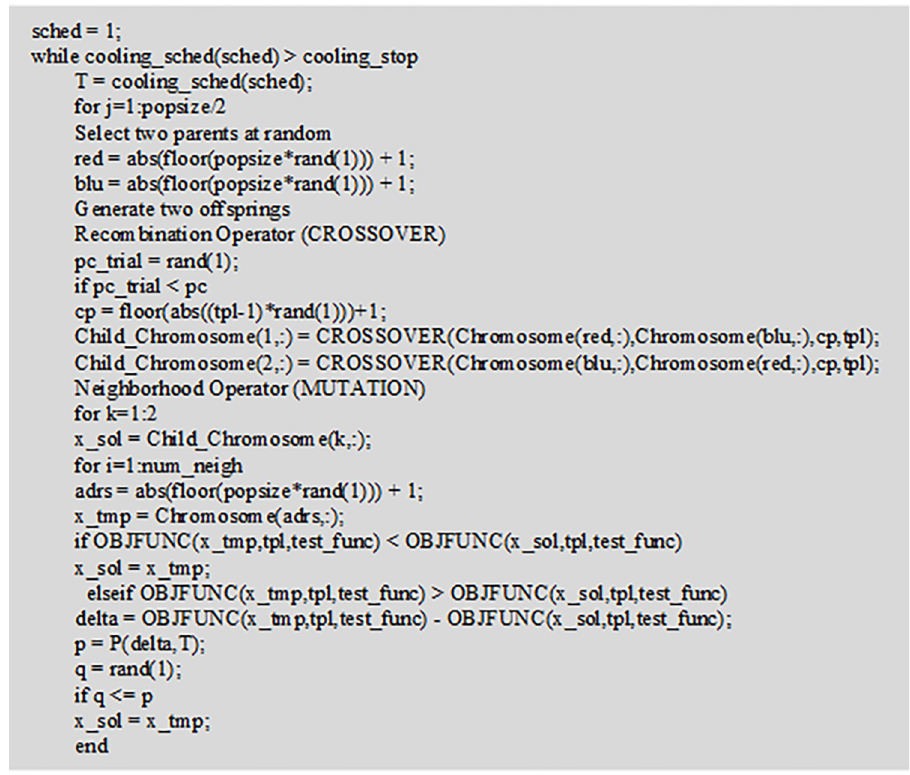
Fig 11. HGSAA model’s partial calculation